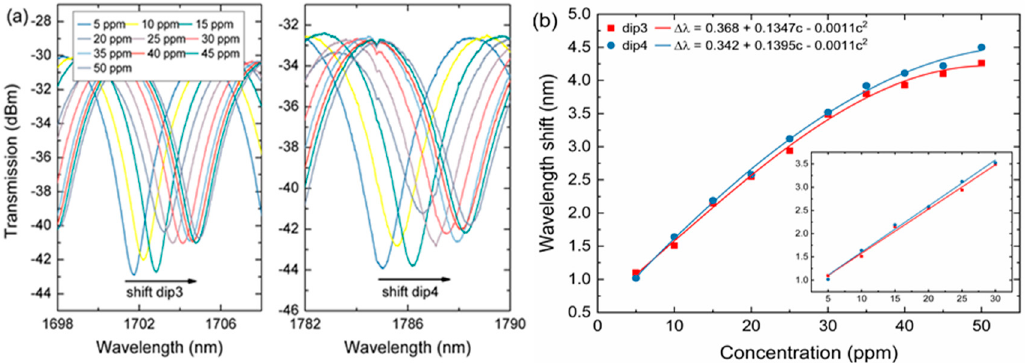
Figure 6. ( a ) Transmission spectra of MFI with different ammonia nitrogen concentration for dip3 and dip4. ( b ) The linear relation between dip position and concentration for dip3 and dip4, the inset is the linear fit for low concentrations of 5–30 ppm.